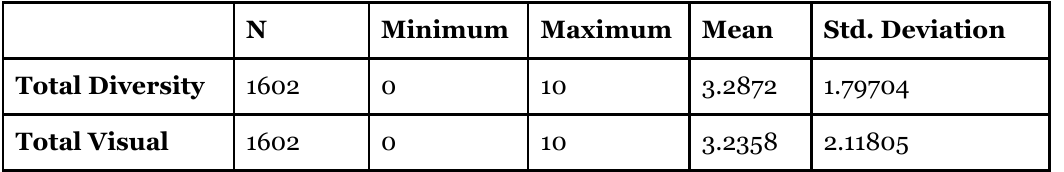
Combined Constructs Descriptive